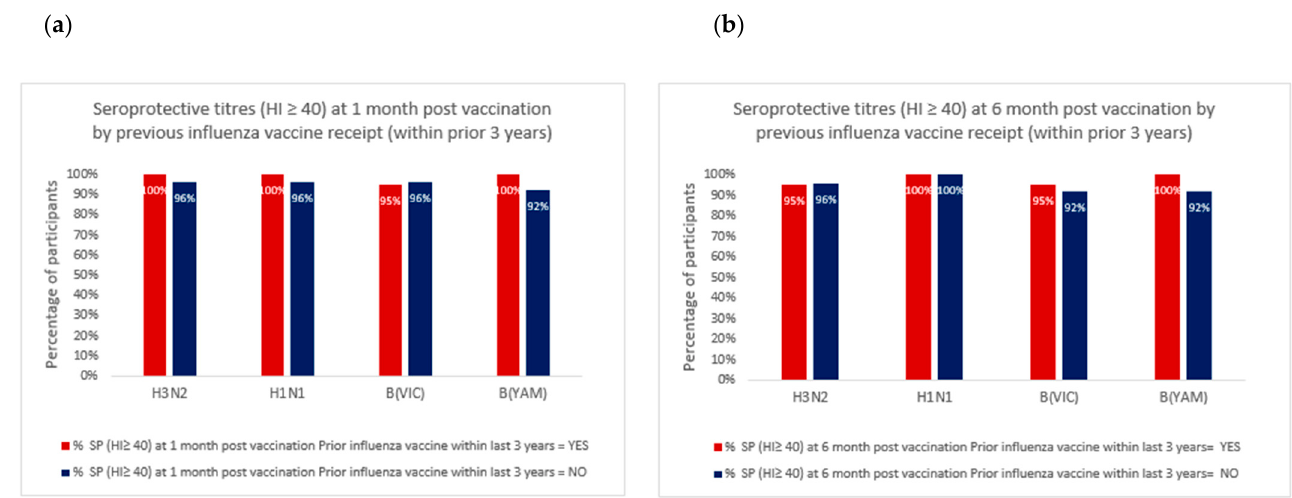
Figure 3. Percentage of participants with seroprotection ( ≥ 40) HI titres at ( a ) 1 month and ( b ) 6 months post-influenza vaccination by recent previous influenza vaccination. Using a higher HI titre threshold of 1:110 to evaluate immunogenicity between groups, the results remained similar between children and adolescents with and without obesity.